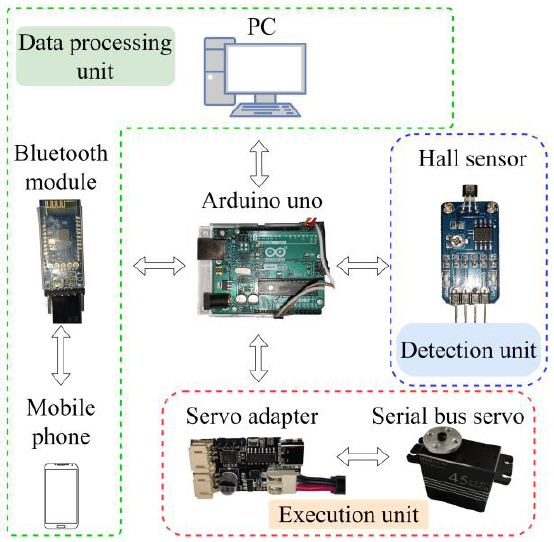
Figure 6. Structure of gripper control system.